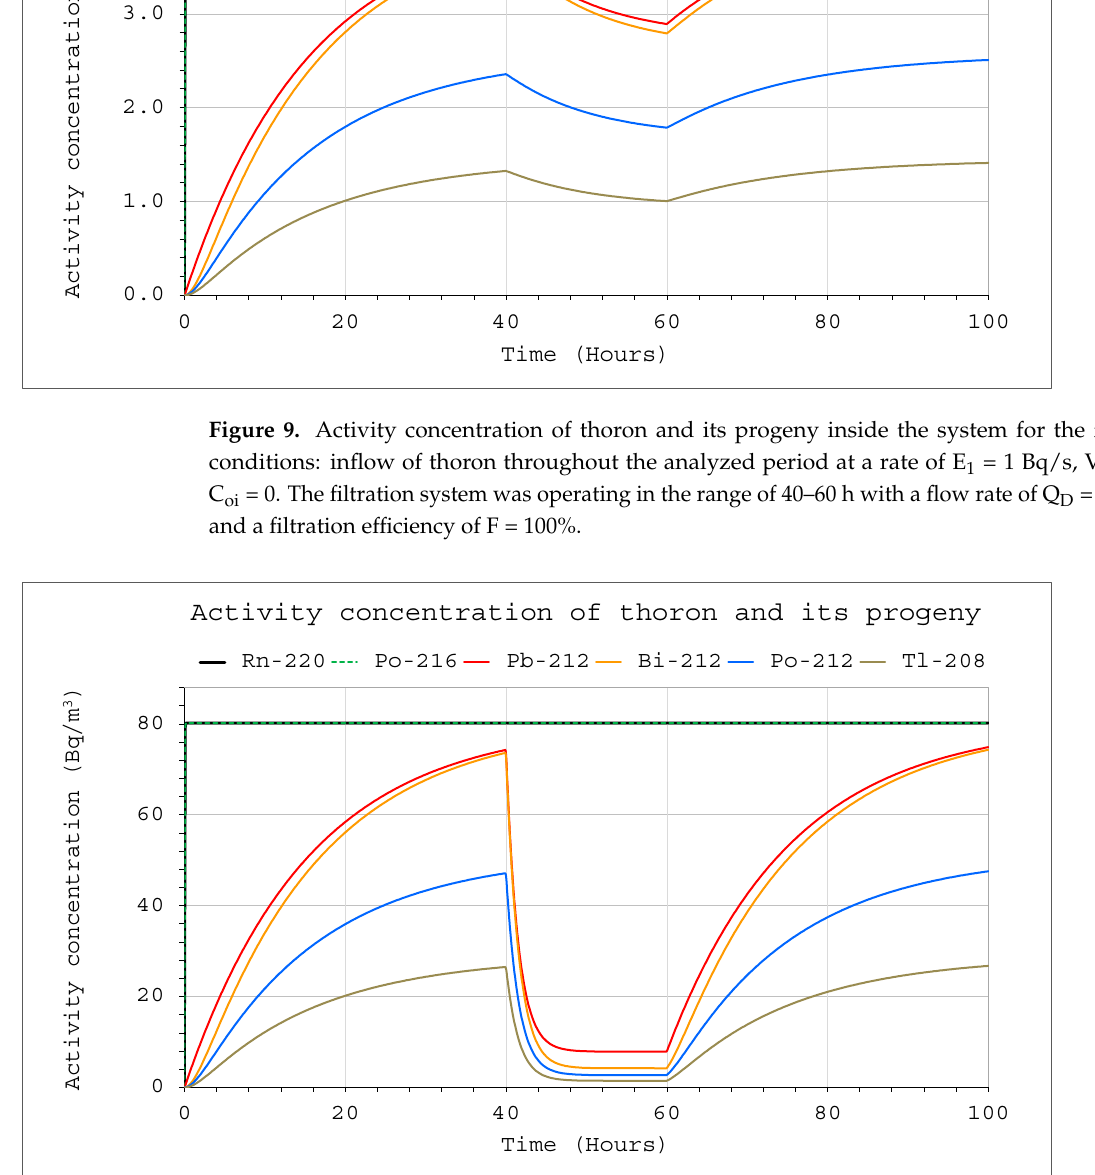
Figure 10. Activity concentration of thoron and its progeny inside the system for the following conditions: inflow of thoron throughout the analyzed period at a rate of E 1 = 1 Bq/s, V = 1 m 3 , C oi = 0. The filtration system was operating in the range of 40–60 h with a flow rate of Q D = 10 L/min and a filtration efficiency of F = 100%.